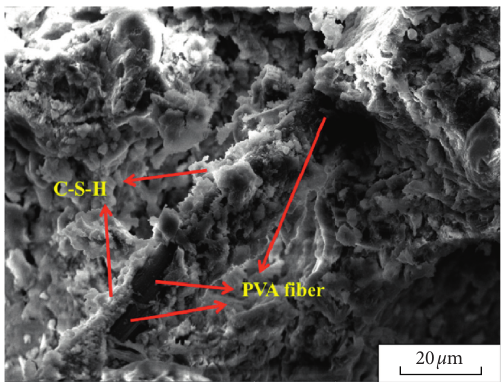
Figure 18: Surface morphology of reference concrete.